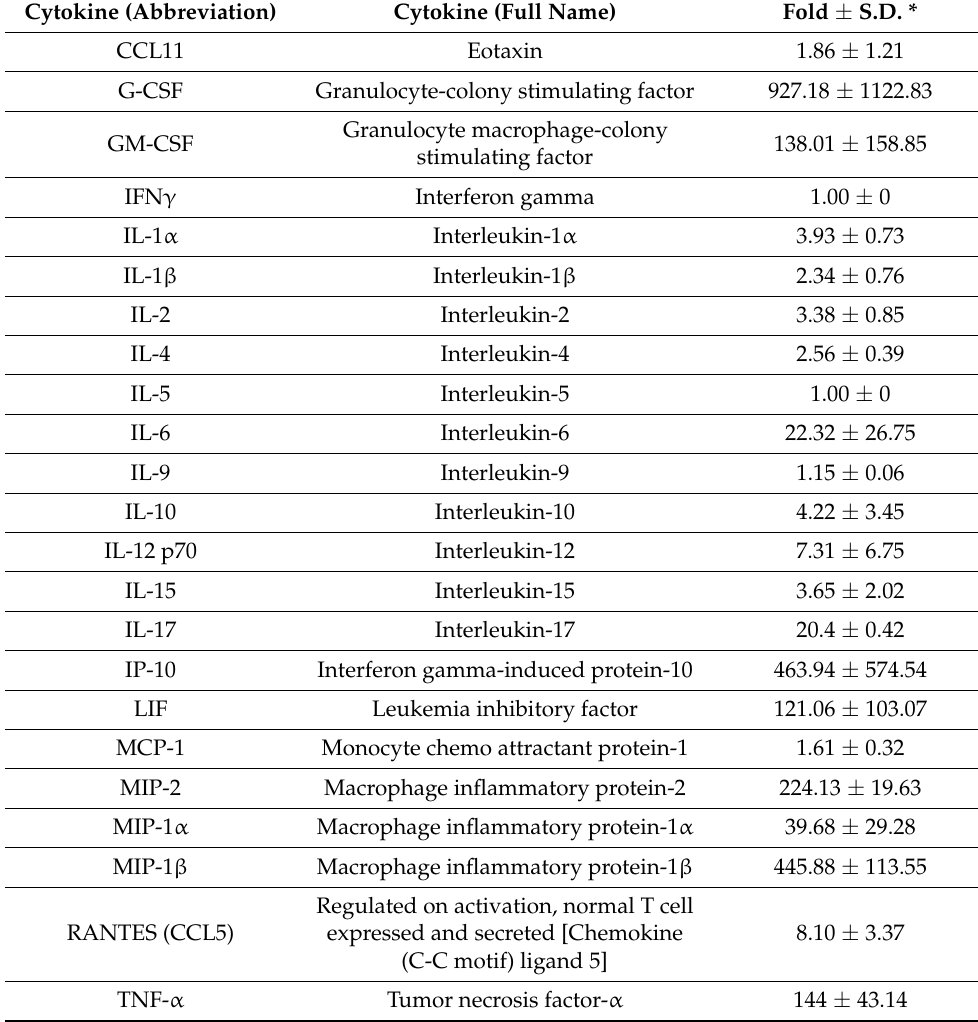
Table 3. Cytokine induction by IMPP-Rb in RAW264.7 murine macrophage